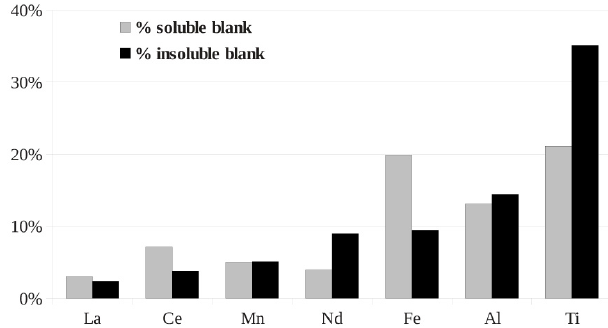
Fig. 3. Ratio of the median quantities in blanks (all the blanks pooled together) relative to both median soluble (grey) and median insoluble (black) quantities in rainwater samples for all the mea- sured